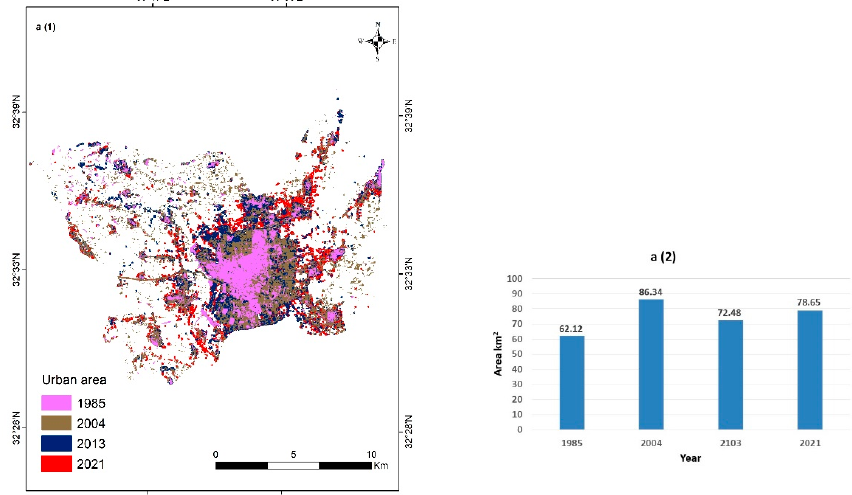
Figure 4. LULC maps of the study area Irbid for ( a ) 1985; ( b ) 2004; ( c ) 2013; ( d ) 2021.